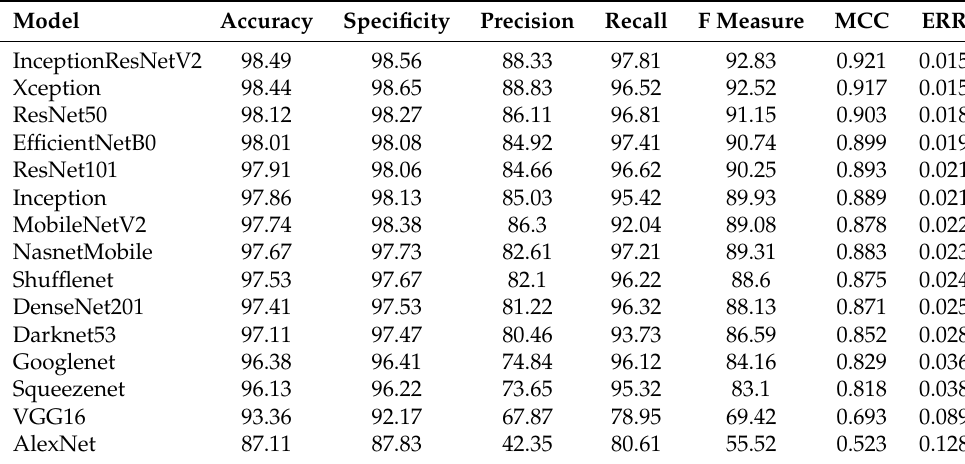
Table 11. Table 11. 5-Fold cross validation of pre-trained models performance.